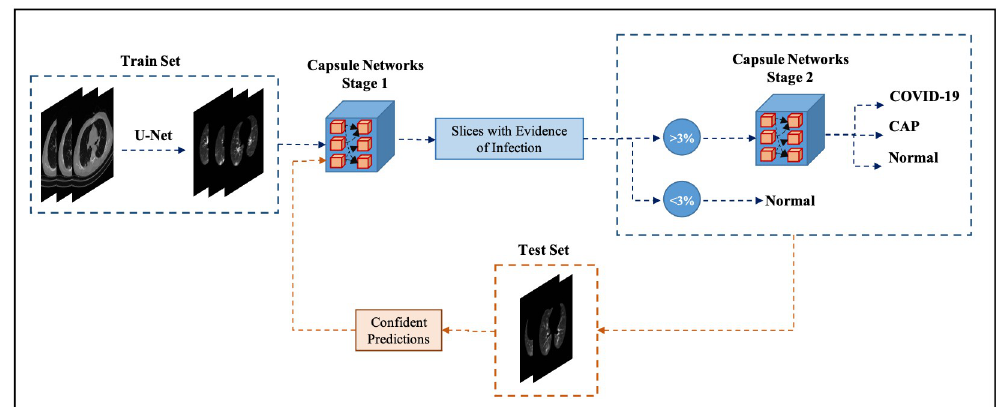
Fig 4. The pipeline of the proposed CapsNets-based